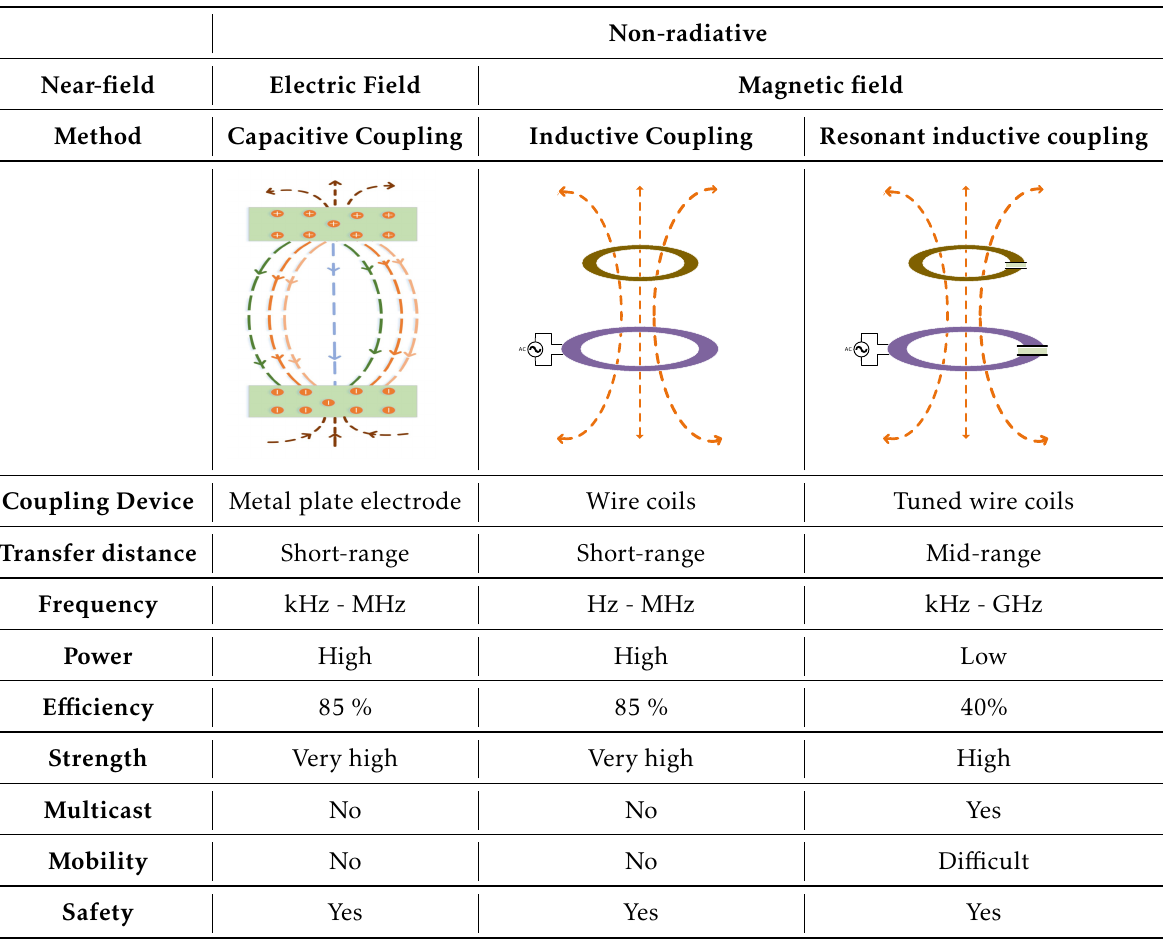
Table 1. Comparison of the Near-field WPT